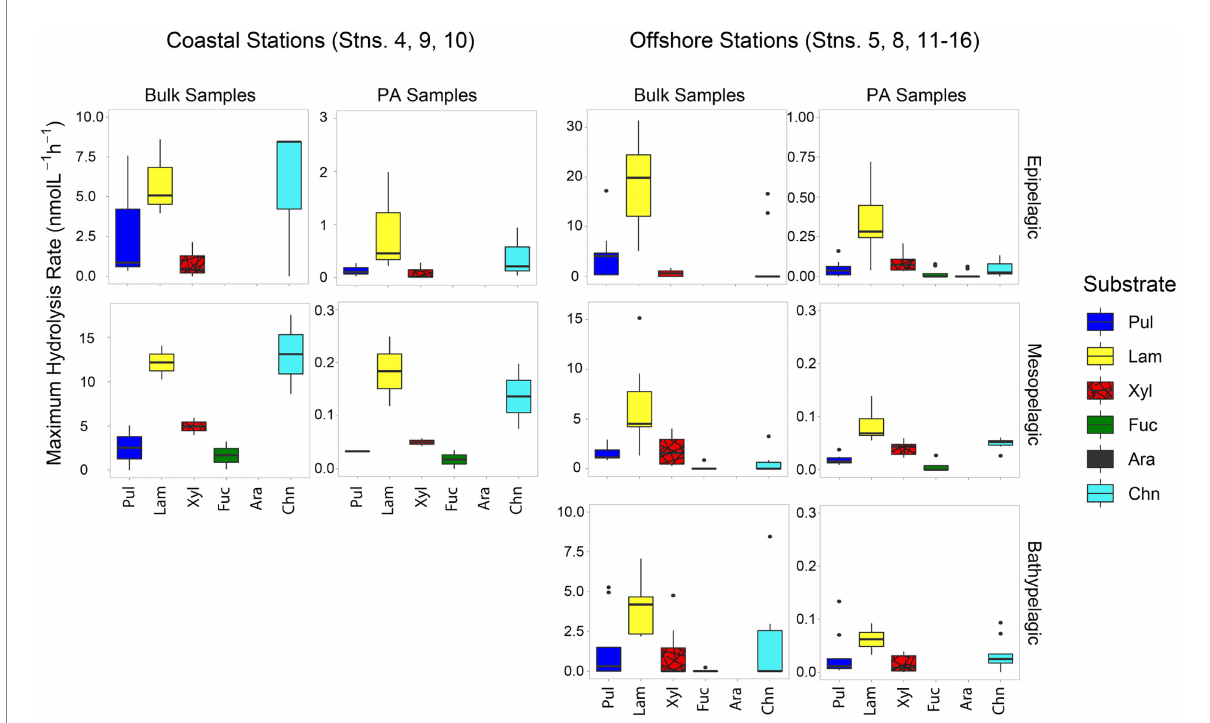
FIGURE 3 Box and whisker plot of maximum polysaccharide hydrolase activities of bulk and PA water samples; line in middle represents median value, top and bottom of the box represents the upper and lower quartile, respectively, ends of ‘whiskers’ represent lowest and highest values (dots: outliers). Coastal stations include Stns. 4, 9, and 10, and offshore stations include Stns. 5, 8, and 11–16. Note that the y-axis differs for bulk and PA samples at each depth. Pul, pullulan; Lam, laminarin; Xyl, xylan; Fuc, fucoidan; Ara, arabinogalactan; Chn, chondroitin